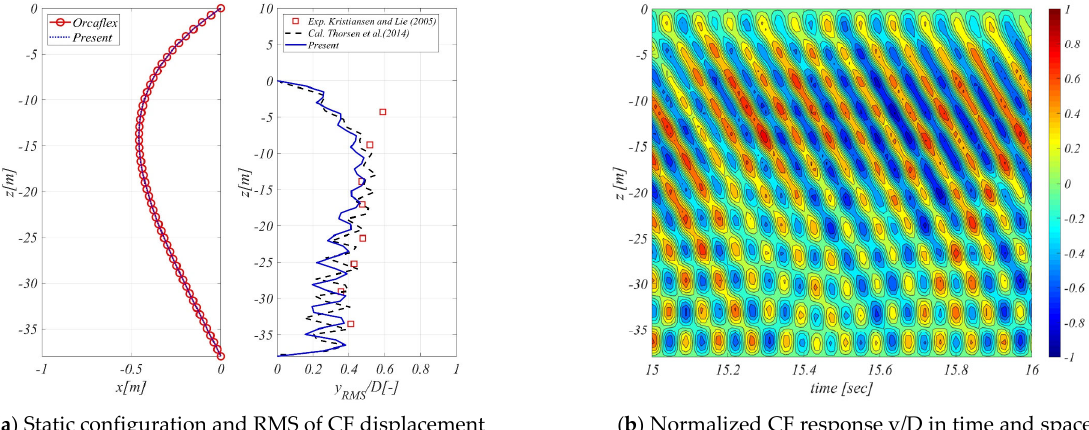
Figure 20. Static configuration and cross flow displacement with shear current ( 𝑈 (cid:3040)(cid:3028)(cid:3051) = 2.0 m/s). In order to analyze the VIV characteristics of a tensioned riser under shear current, VIV responses at three points (near the top, middle, and bottom) of the riser under the shear current of 𝑈 (cid:3040)(cid:3028)(cid:3051) (cid:3404) 1 . 3 m / s are presented in the time and frequency domains in Fig ‐ ure 21. Figure 21a shows the VIV responses at the three points in the time history. Unlike regular wave response in the CF on the uniform current condition, an irregular response with multi ‐ frequencies is observed at all three points. Multi ‐ frequencies components of VIV responses from other points due to the shear current are presumed to propagate and be superposed along the riser. The phenomenon is further analyzed with the frequency results in Figure 21b. The peak frequency of 7.5 (Hz), resonance frequency with the 9th natural frequency (7.335Hz) of the riser, is observed at different three points. Considering the natural frequencies of the riser model, VIV components with 7.5 (Hz) of frequency induced by 1.04 m/s of flow speed at − 7.6 m of the riser excites the riser, resulting in reso ‐ nant with the 9th natural frequency of the riser. It is found that a tensioned riser under the shear current vibrates in crossflow with multi ‐ frequencies riding one dominant frequency.